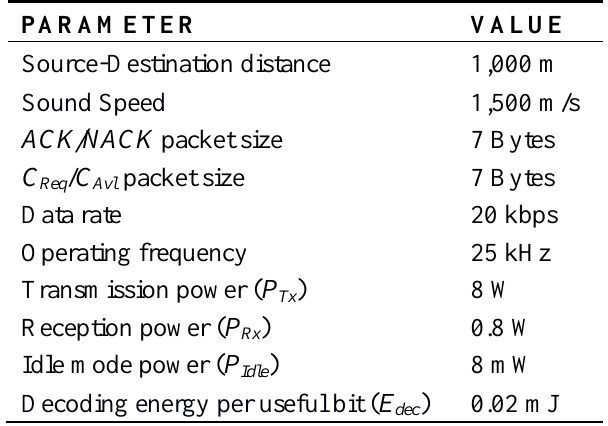
Table 1. Simulation Parameters and Acoustic Modem